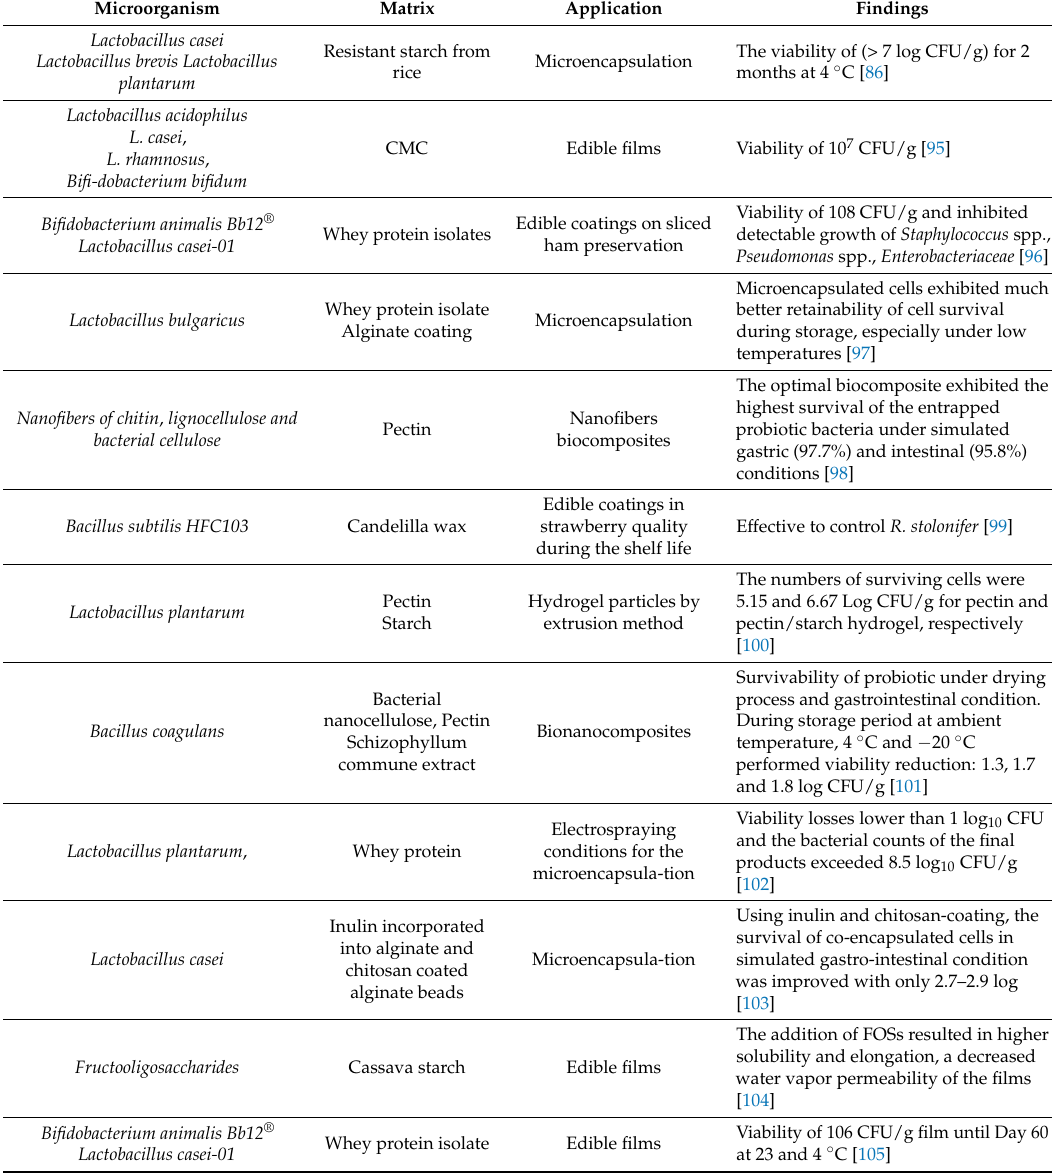
Table 3. Recent studies that containing probiotic and pre-biotic in different